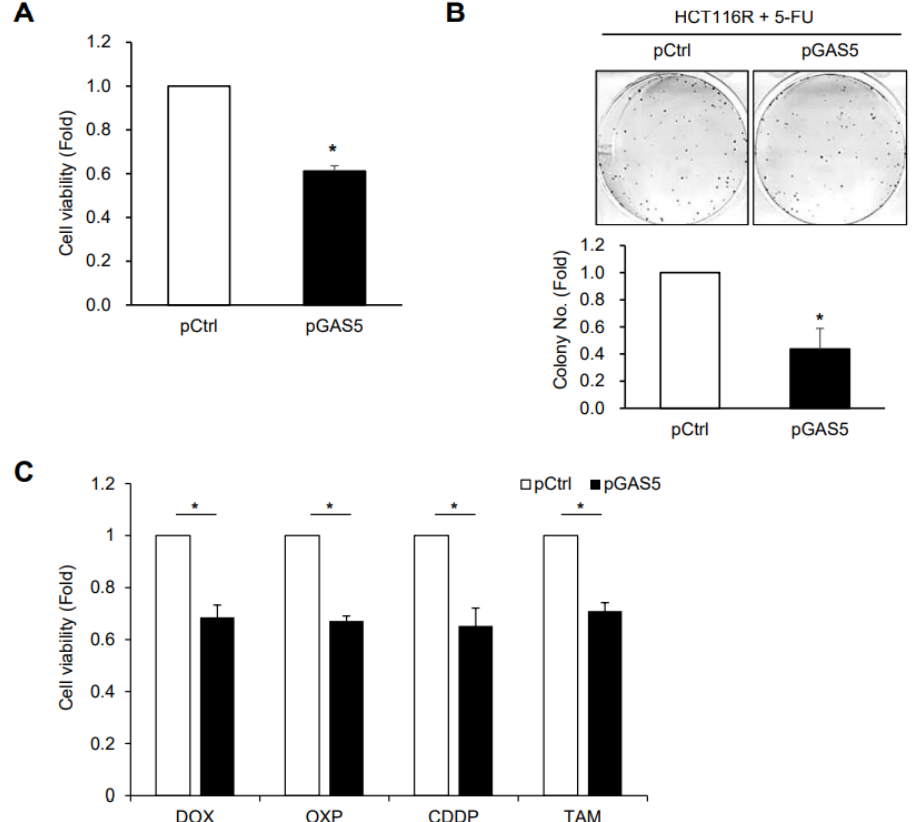
Figure 6. Sensitization of resistant cells by ectopic expression of GAS5. ( A , B ) HCT116R cells were transfected with plasmids and further incubated with 5-FU for 48 h. Cell viability was assessed by MTT assay ( A ) and colony-forming assay ( B ). ( C ) HCT116R cells transfected with plasmids were incubated with various anti-cancer drugs such as doxorubicin (DOX), oxaliplatin (OXP), cisplatin (CDDP), and tamoxifen (TAM) for 48 h, and cell viability was assessed by MTT assay. Data were expressed as mean ± SEM, and images are representative of three independent experiments. The statistical significance of the data was analyzed via Student’s t -test; *, p < 0.05.